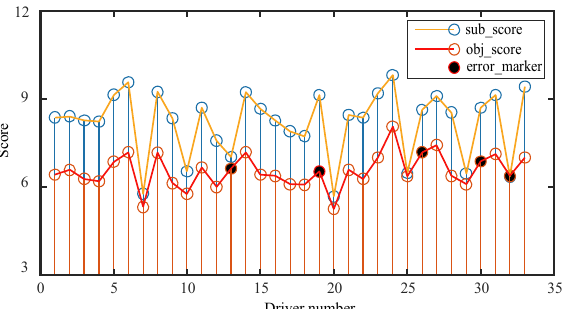
Figure 14. Correlation analysis of the subjective score and objective risk coefficient of driving styles.